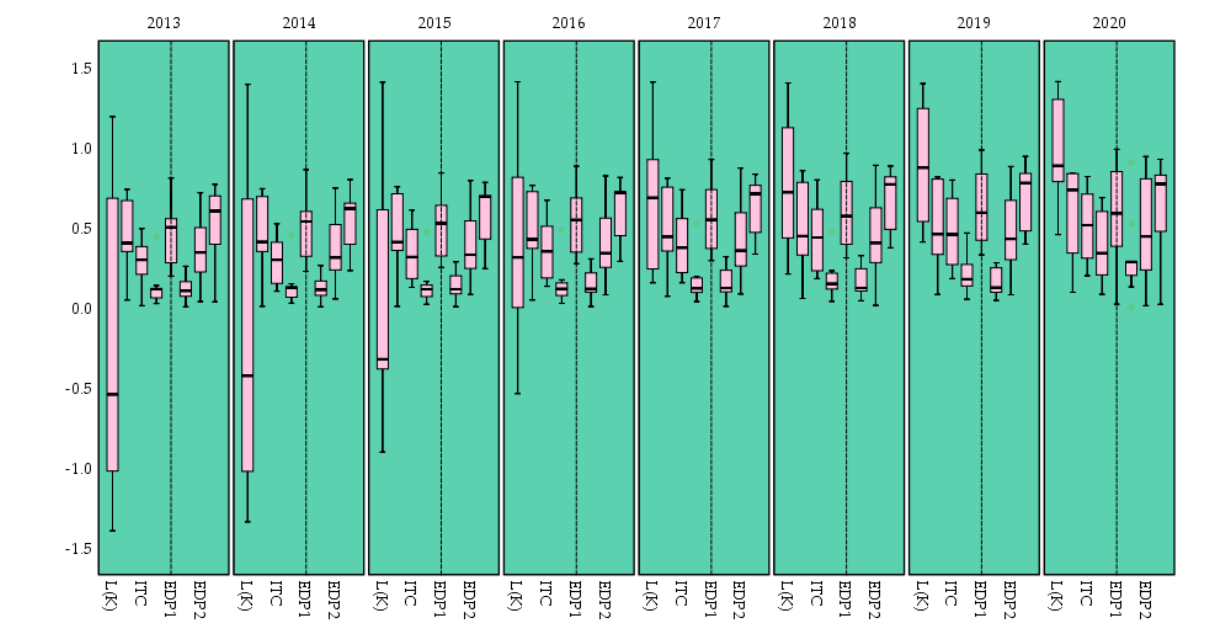
Figure 8. Descriptive statistical analysis results. Table 6. Model optimization and selection